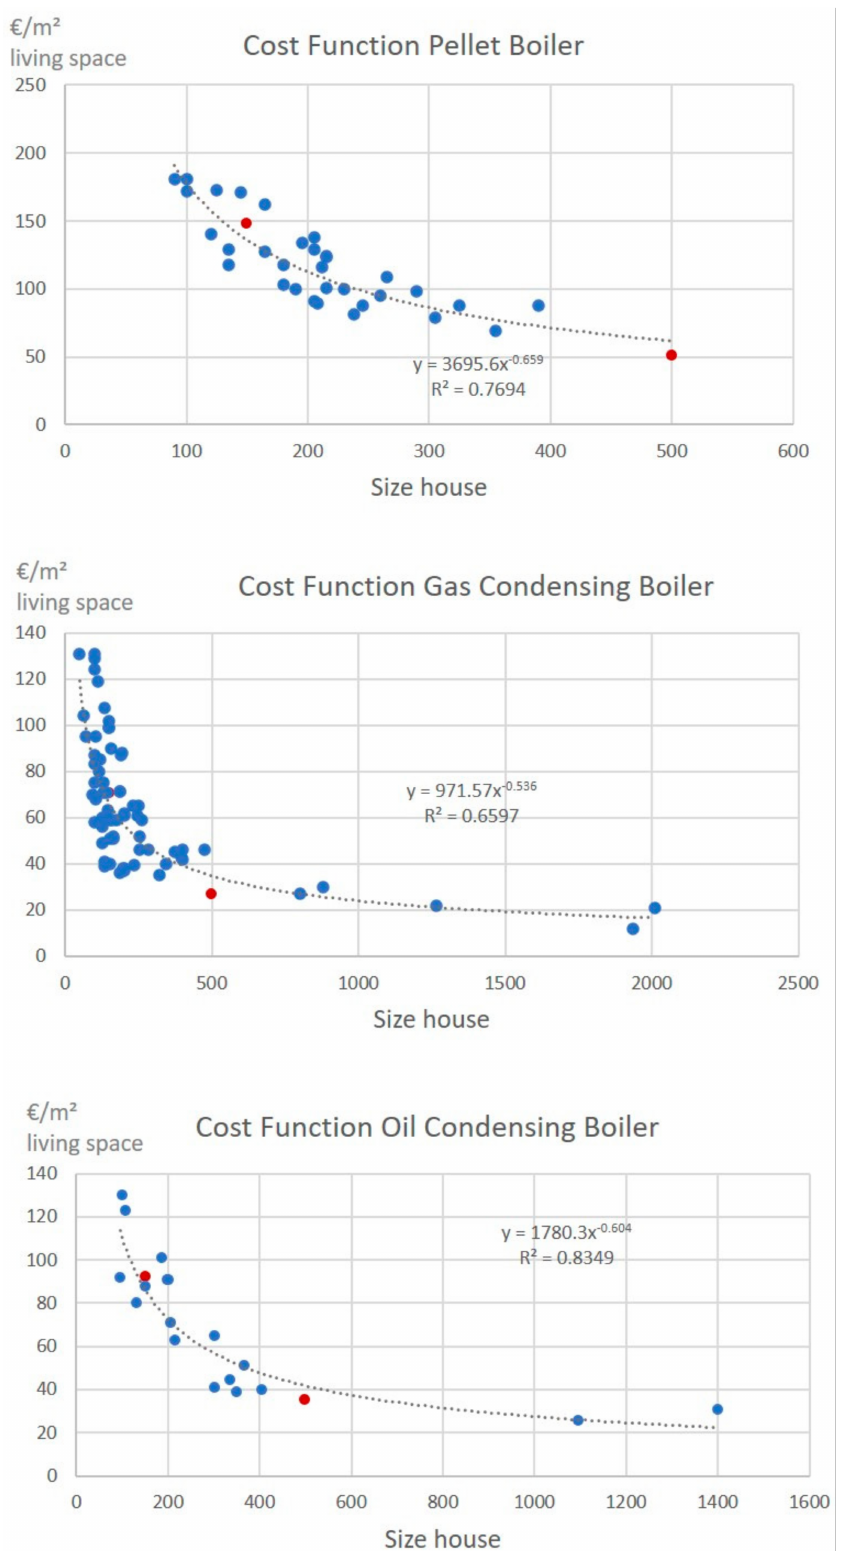
Figure A1. Calibrated cost functions for some heating systems with data from [61] (p. 51) and [46] (marked dark